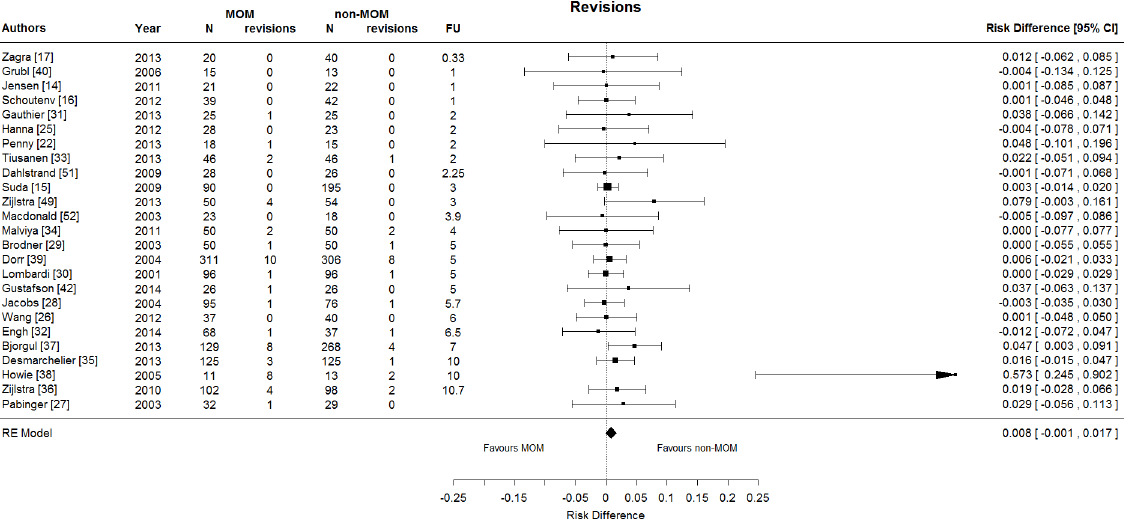
Fig 3. Forest plot showing the risk difference in revision surgery between MOM and non-MOM THA. There is significantly more revision surgery for MOM THA compared to non-MOM THA. RE model = random effects model.